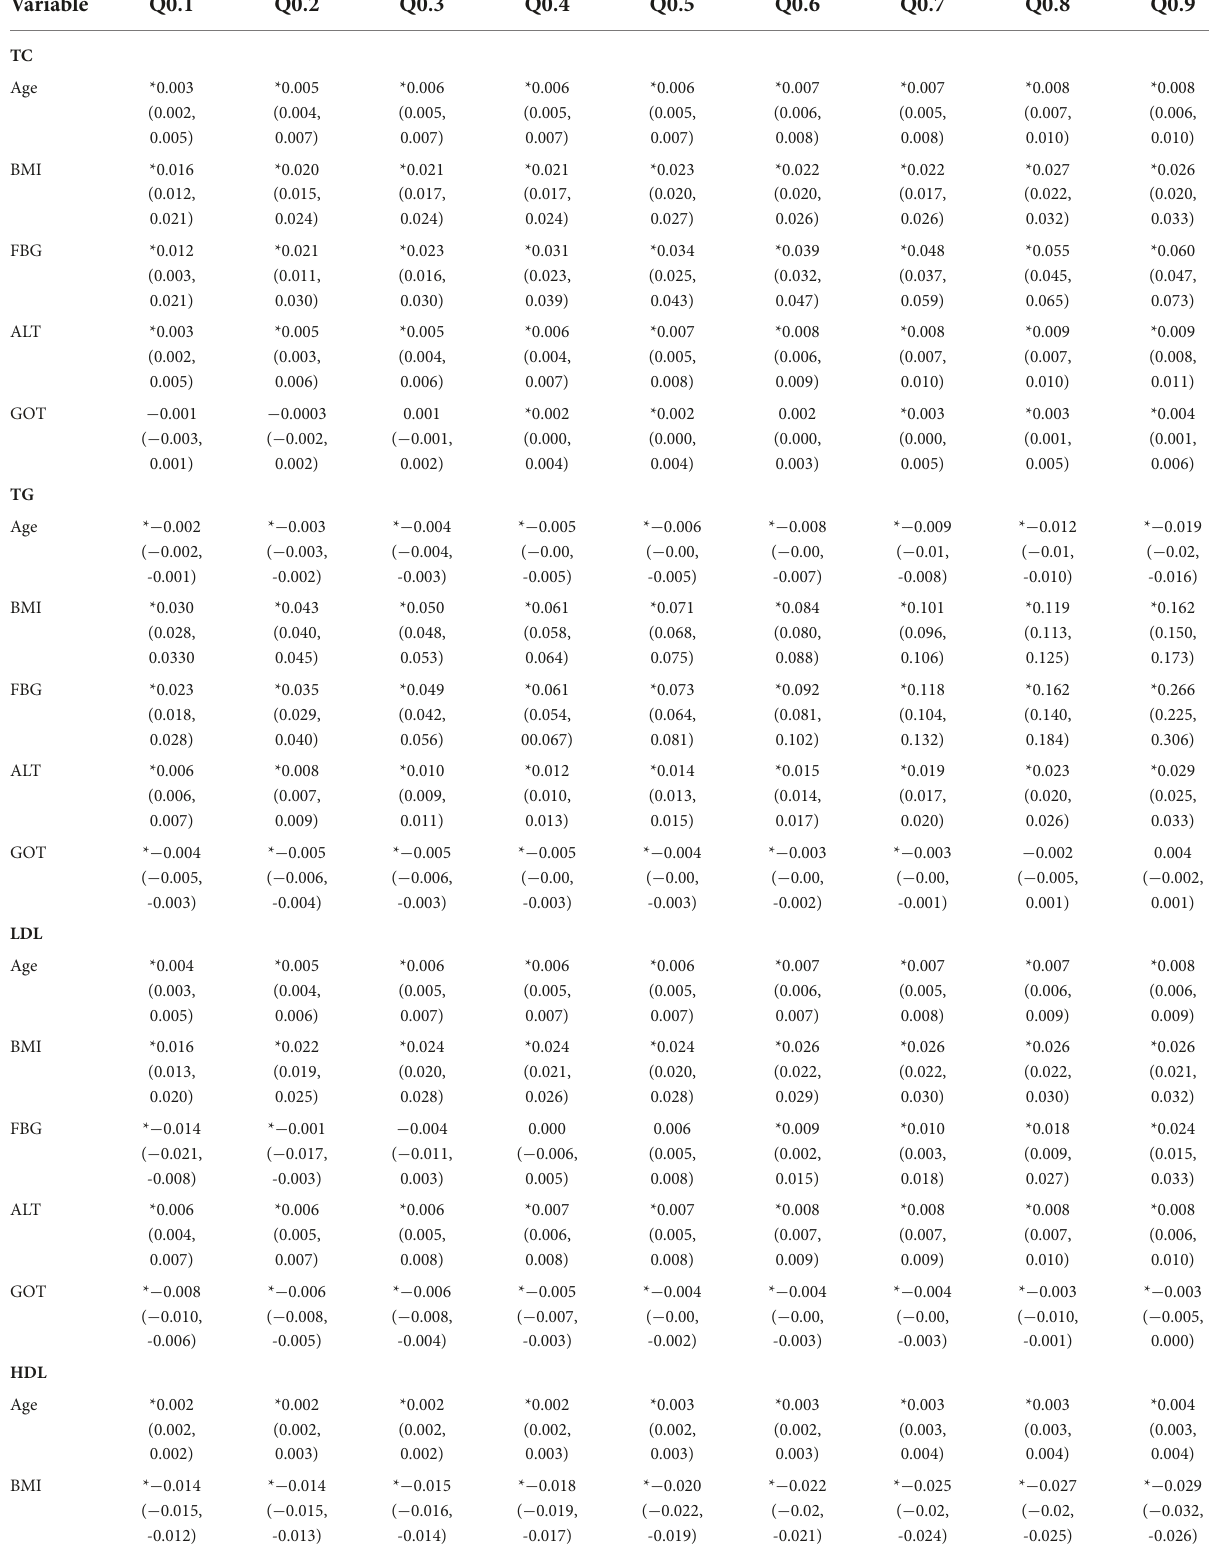
TABLE 2 Quantile regression coefficients and 95% confidence intervals between lipid levels and variables for males.